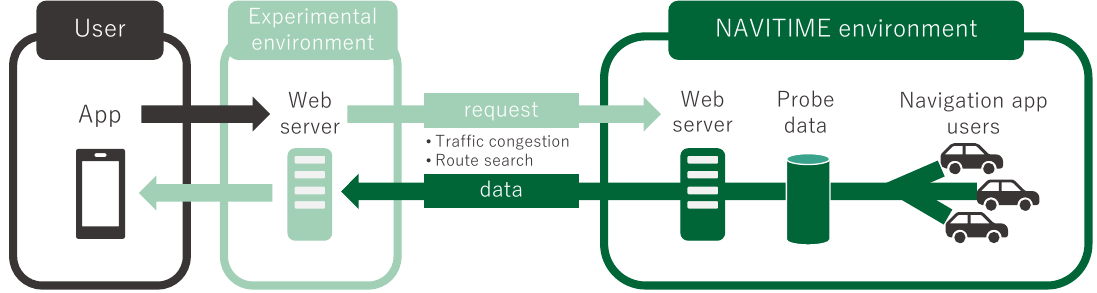
Figure 2. Screenshot of the English version of the app: ( a ) Route choice; ( b ) Spot choice; ( c ) Route check.